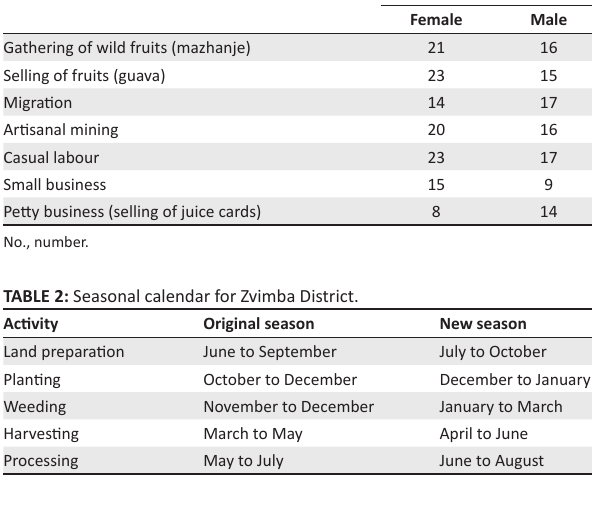
TABLE 1: Adapting strategies for Zvimba District. Type of